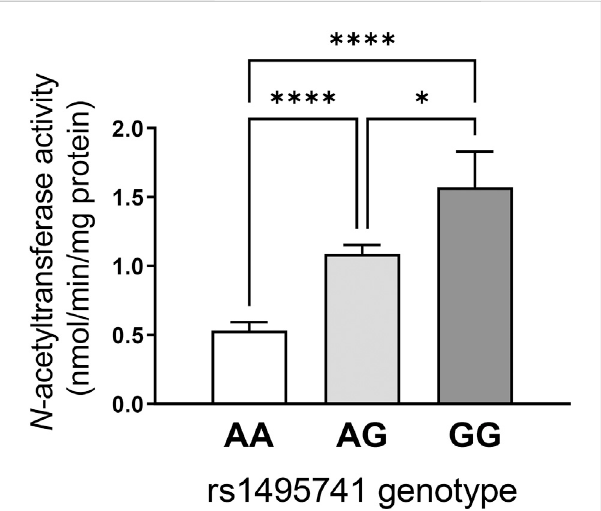
FIGURE 2 rs1495741 genotype-dependent changes in NAT2 activity in cryopreserved human hepatocytes. Bar graphs showing NAT2 activities (measured by N -acetylation of sulfamethazine) in cryopreserved human hepatocytes from 154 individuals of European background. Data was categorized by genotypes of rs1495741, a non-coding NAT2 SNP (i.e., AA, AG, and GG). The “ G ” allele represents the dyslipidemia allele (see Table 1 and Supplementary Table S1). One-way ANOVA analysis was done followed by Tukey ’ s multiple comparison test. *, p < 0.05. ****, p